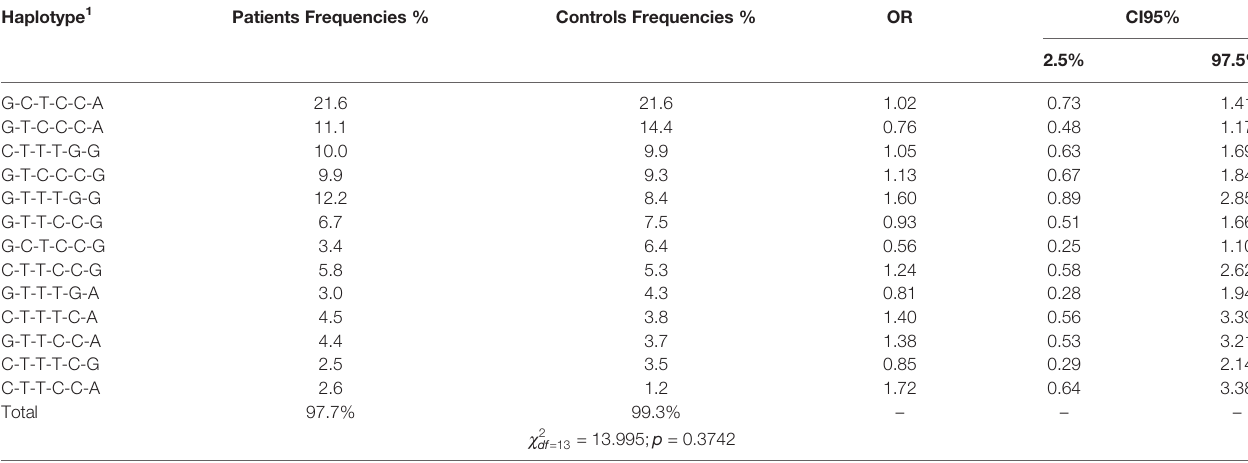
TABLE 3 | Haplotype frequencies in patients and control group among smokers. Haplotypes were sorted by control frequencies. Haplotype 1 Patients Frequencies %